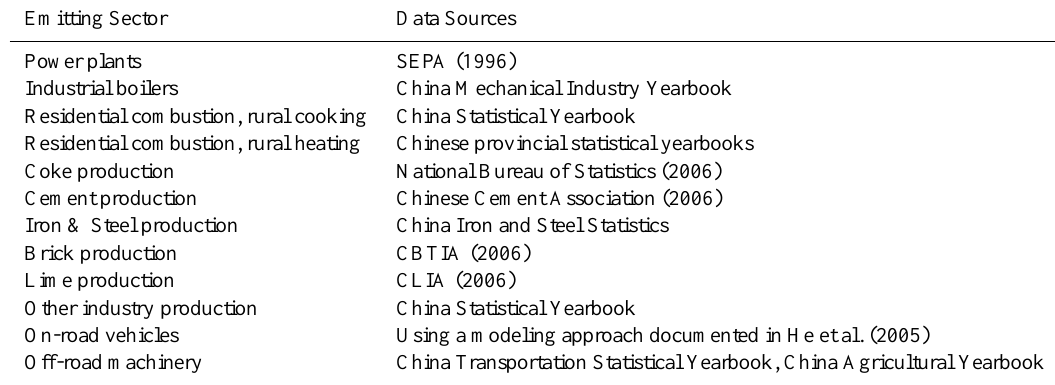
Table 1. Data source of technology distributions for main PM emitting sectors in